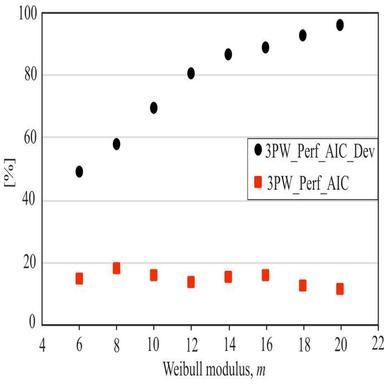
Fitting performance of 3P-Weibull distribution function as a function of Weibull modulus.